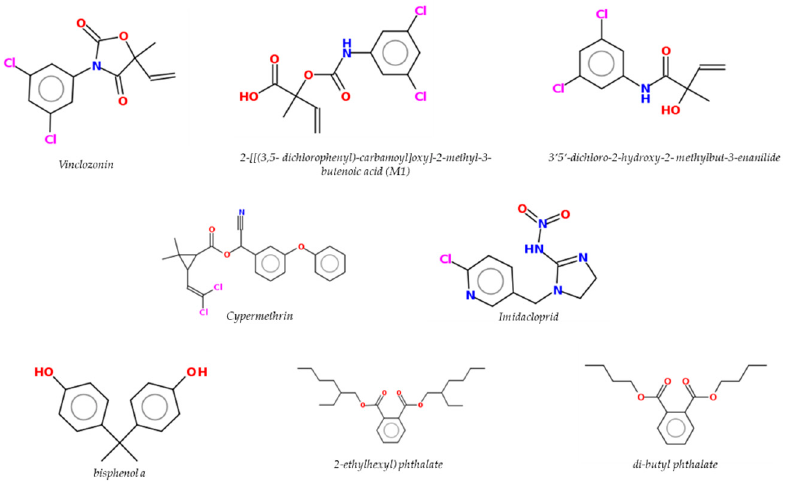
Figure 3. Chemical structures of pesticides/biocides and plasticizers.